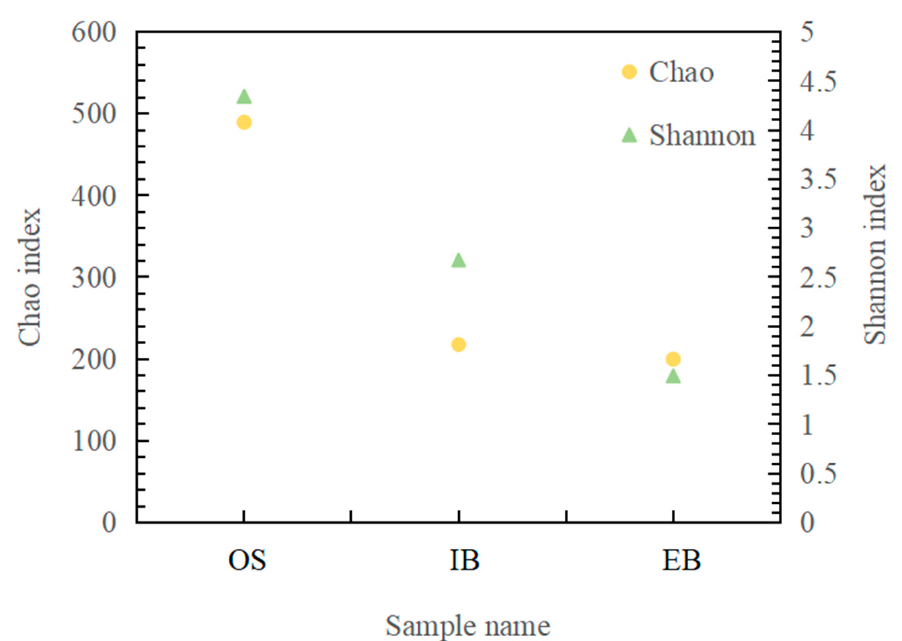
Figure 4. Biological diversity of the original seawater (OS) and the immobilized petroleum–degrading bacteria beads in different areas of the bioreactor (water inlet site (IB); water outlet site (EB)). (Shannon indices are shown as green triangles; Chao indices are shown as yellow circles.)